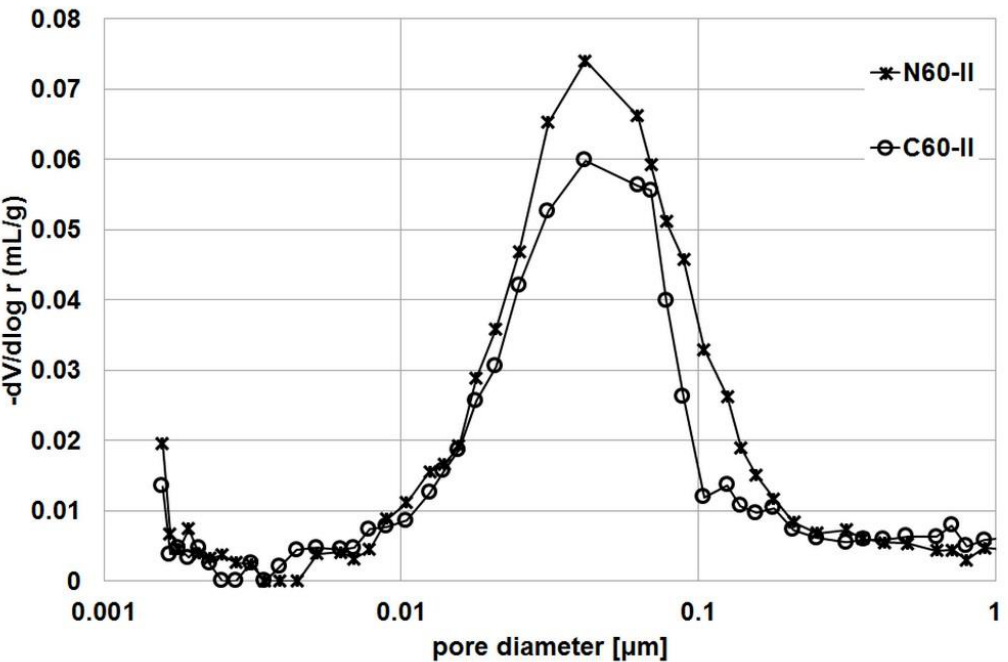
Figure 6. Pore distribution in R45-II series.